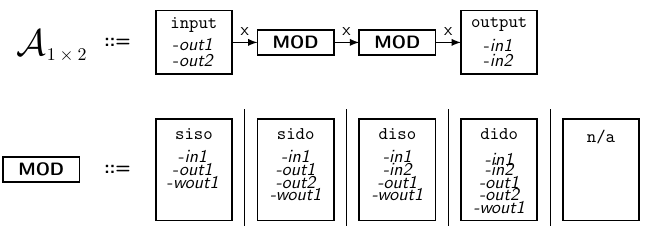
Figure 6. Top: start graph representing an unspecified 1 transformation rule to replace unspecified modules by individual modules ( siso to n/a ).